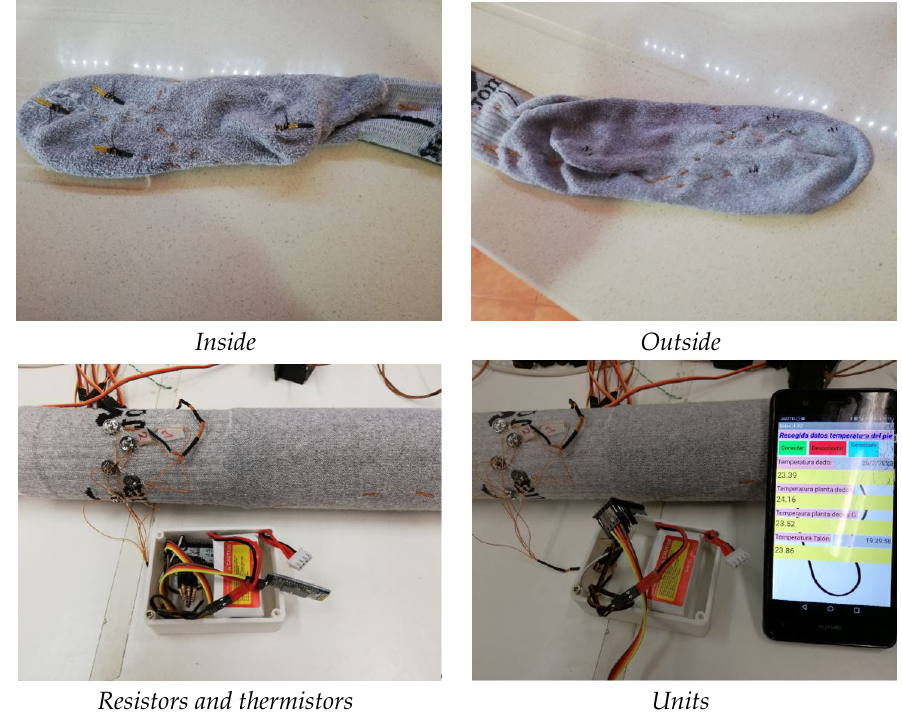
Figure 11. Smart sock working. In the top part we show details of one of the socks with the sensors. In the bottom, readers can see the smart sock working connected to the cell phone